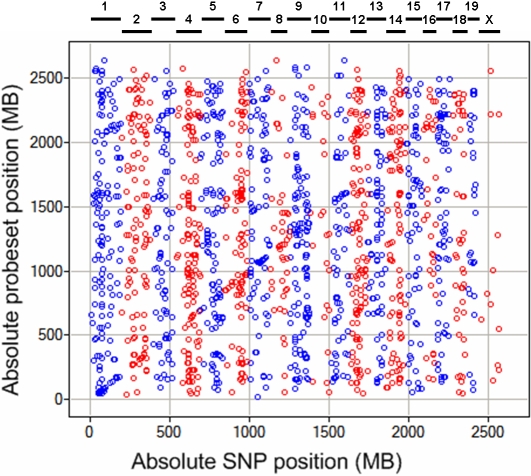
The global view of eQTL mapping results adipose tissue.The x-axis shows the absolute genomic position on the SNP/QTL axis (chromosomes shown in alternating colors), and y-axis shows the absolute genomic position of the genes whose expression was measured. Each data point in the graph represents an association between the genotype at a specific genomic locus and the expression of a gene. The strong diagonal pattern is called the “cis-eQTL band” and represents an association between the expression level of a gene and the genotype at the gene's locus. In addition, multiple vertical bands (“trans-eQTL bands”) illustrate associations between the expression of many genes and the genotype at a single genomic locus. For clarity, only data points with association scores greater than 4.2 are shown (roughly 5000 data points).